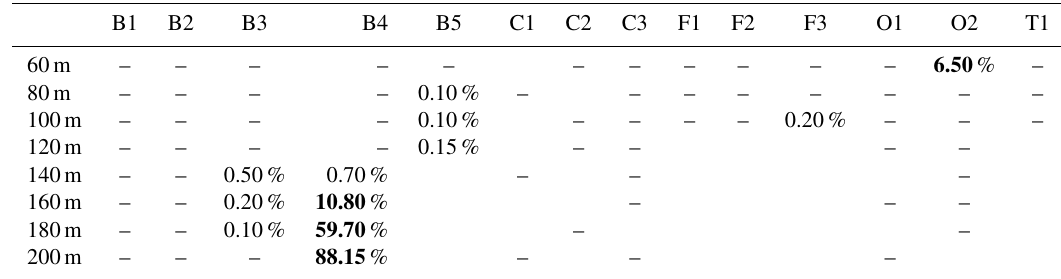
Figure 3. Difference of wind speed histograms between reanalyses and observations for COSMO-REA6 (a) , ERA5 (b) , MERRA-2 (c) in bins of 1ms − 1 for all observation sites at 100m height level. Yellow/red color (cyan/blue) indicates a positive (negative) difference to the observations. Table 2. The probability at each observation location and height that the wind speed follows a Weibull distribution. A horizontal line indicates that the p value is below 0.05%. Bold numbers represent p values above the significance level of